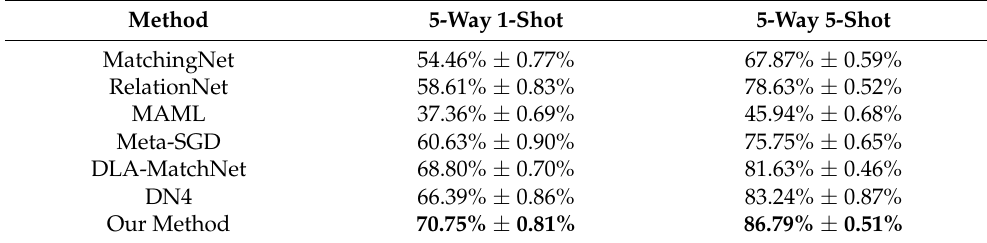
Table 2. Experimental results of different methods on the NWPU-RESISC45 dataset.